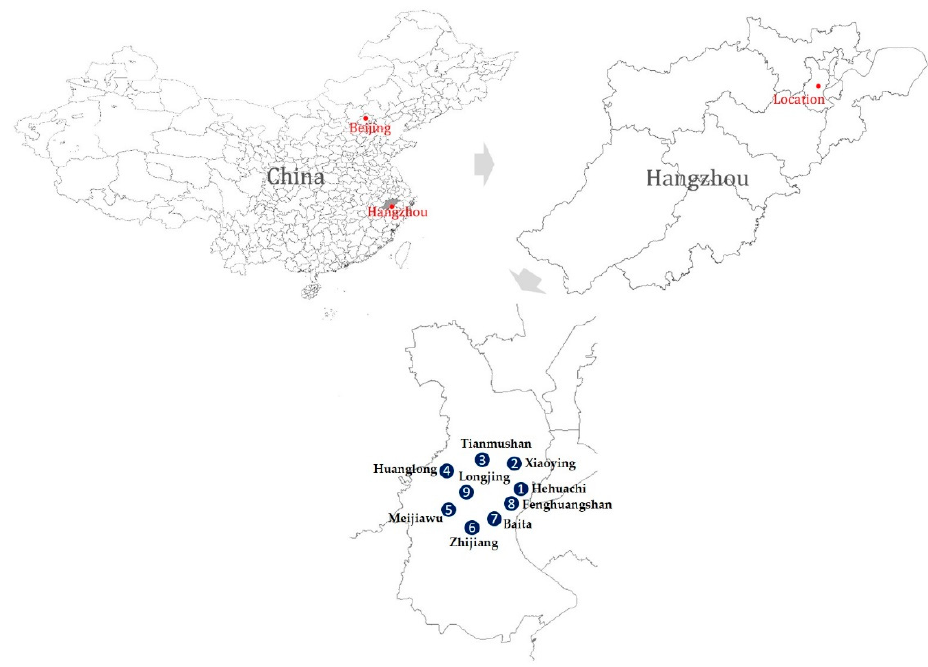
Figure 2. Location of the communities.